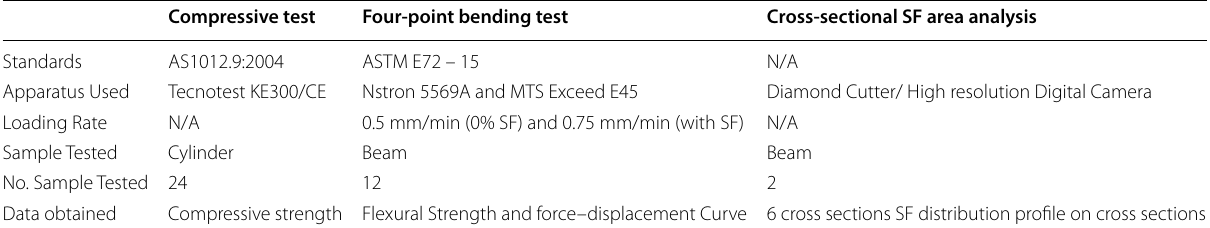
Table 2 Details of testing